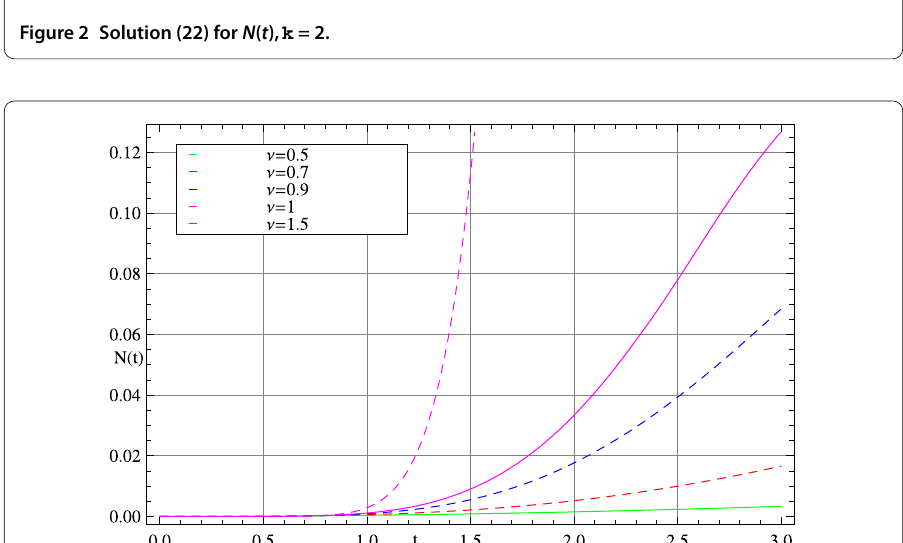
Figure 3 Solution (22) for N ( t ), k =